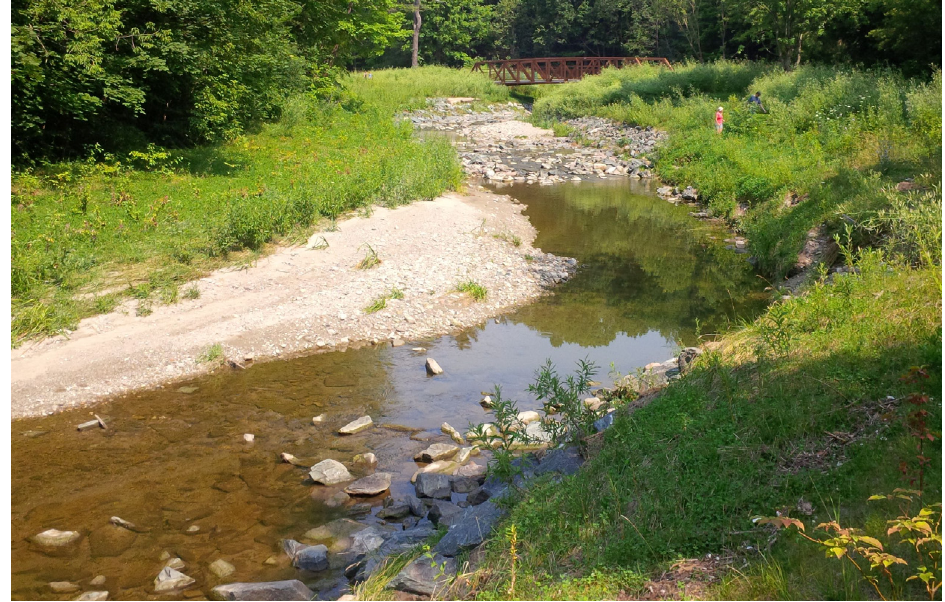
Figure 3. Photograph of restoration site July 2013, approximately 18 months after construction. Note the rocky riffle upstream of the pool in the middle of the frame and the point bar largely formed from deposited sand and gravel. Flow is from top to